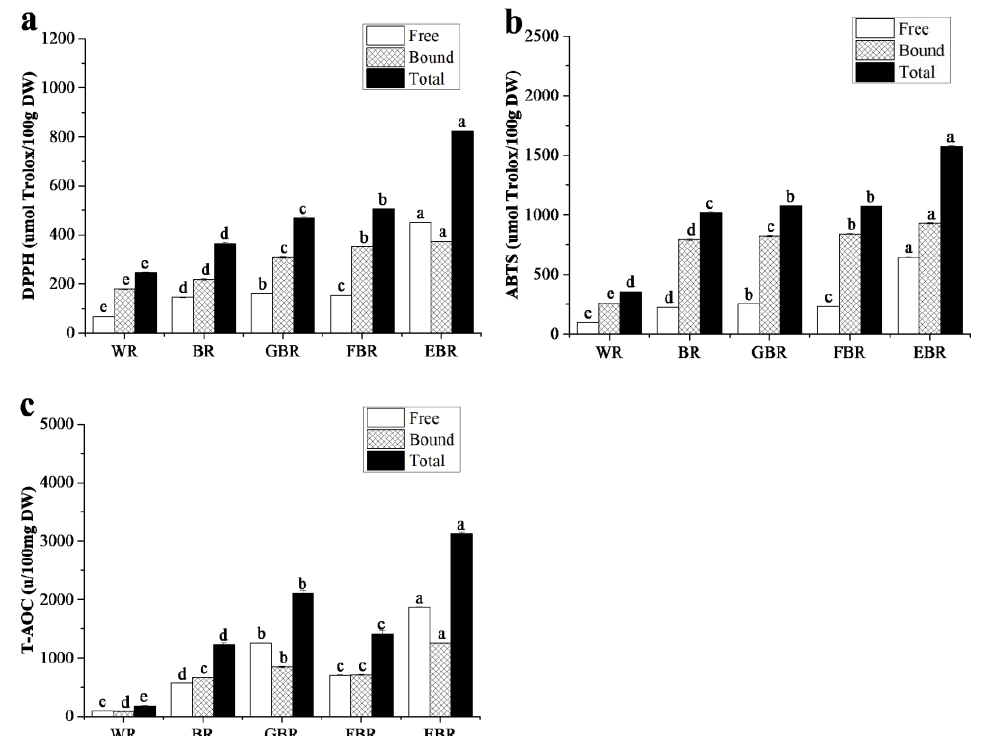
Figure 1. Antioxidant activity of different brown rice products (n = 3). (a) DPPH free radical scavenging capacity. (b) ABTS free radical scavenging capacity. (c) Total antioxidant capacity (T-AOC). The data columns are mean ± standard deviation from four independent experiments (WR—white rice, BR—brown rice, GBR—germinated brown rice, FBR—fermented brown rice, EBR—extruded brown rice). Different lowercase letters indicate significant differences among processing techniques ( p < 0.05). DW: dry basis weight.